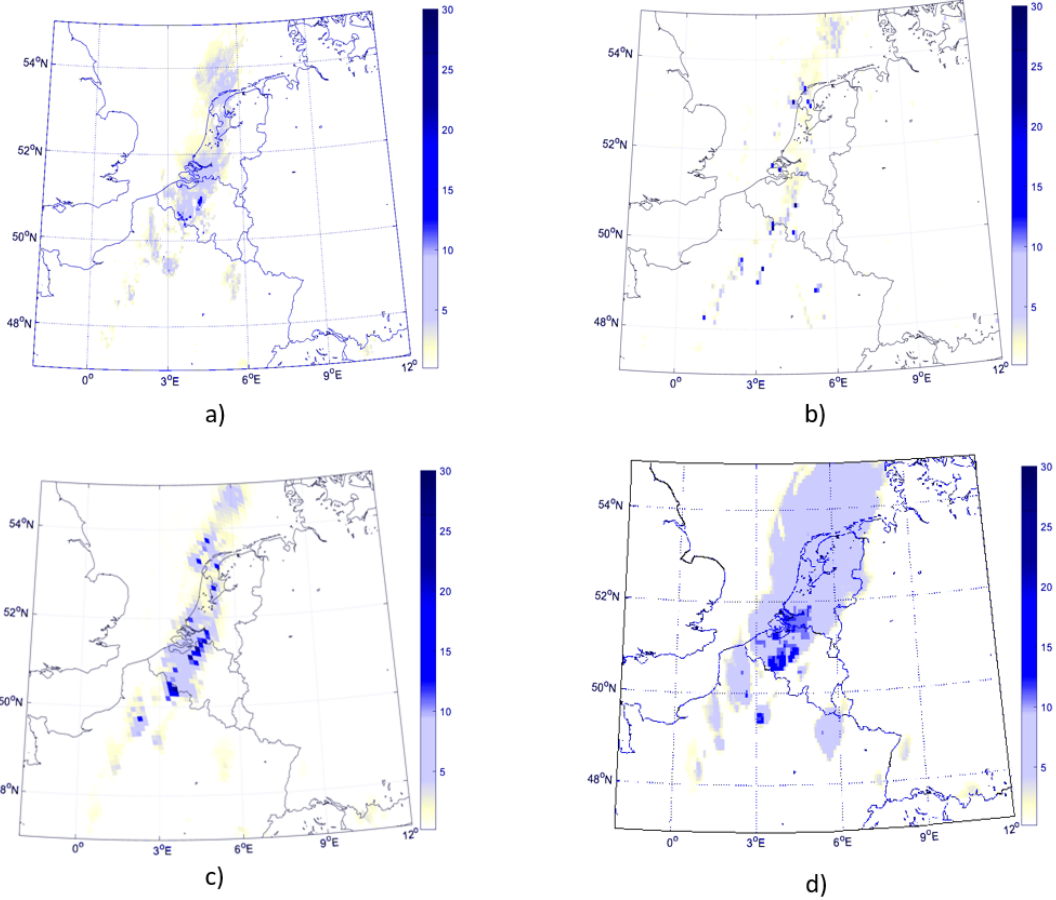
Figure 3. Rain Rate data (mm/h). ( a ): NN retrieval—5 June 2015 17:30; ( b ) Radar ground-truth—5 June 2015 17:30; ( c ) SSMIS-Rain Rate—5 June 2015 17:25; ( d ) H03 product—5 June 2015 17:30.